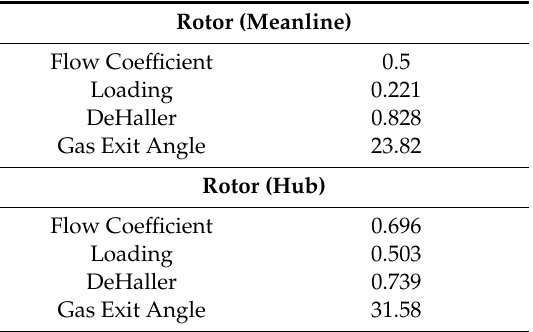
Table 8. Results from the 1D meanline analysis for the design point 4, iteration 1.